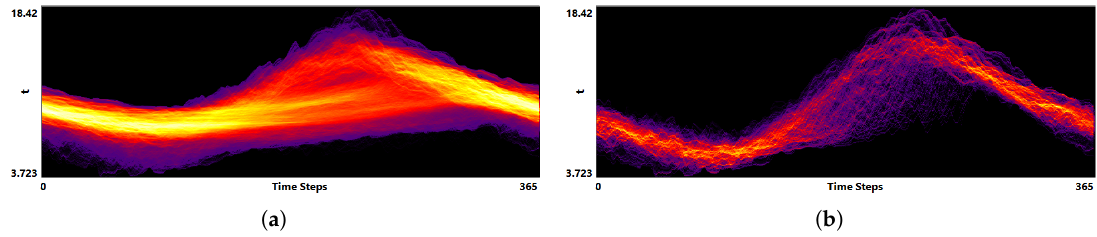
Figure 21. ( a ) Function plot for water temperature aggregated over all simulation years. ( b ) Function plot for water temperature when filtering the trajectories according to the small area highlighted in Figure